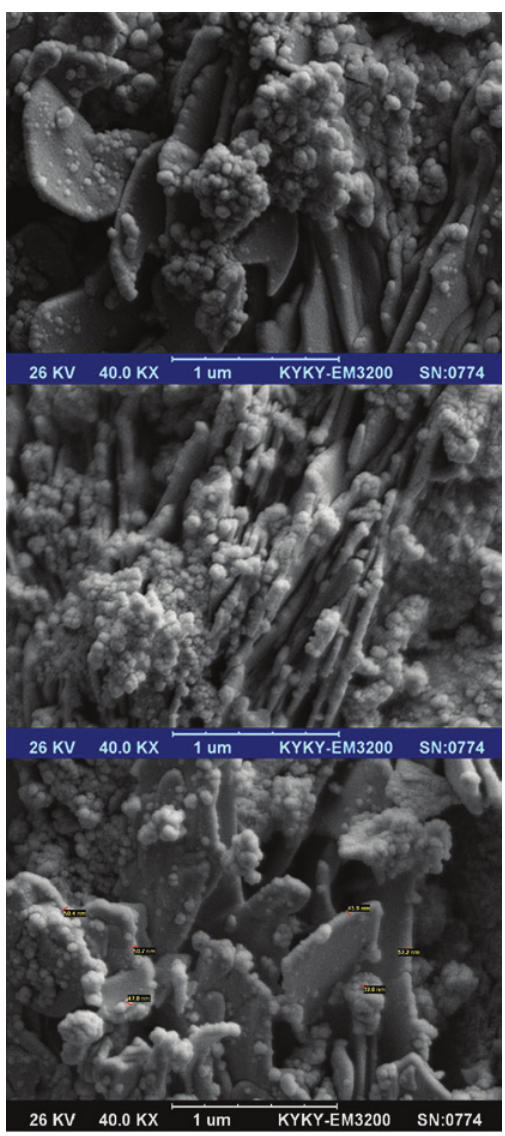
Figure 3: SEM images of cobalt-doped PbS obtained in the pres- ence of glucose. Figure 4: SEM images of copper-doped PbS